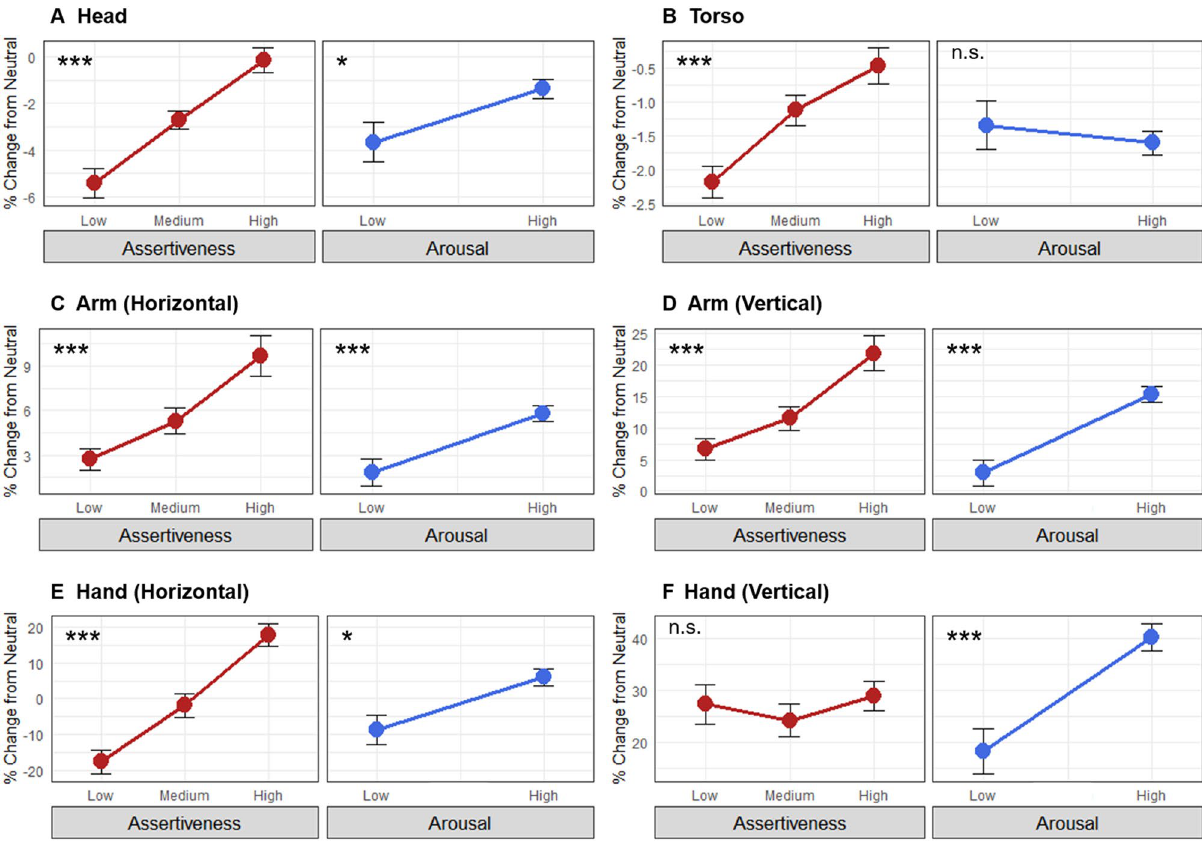
Figure 3. Body effects of character assertiveness and emotional arousal. The figure shows the effect of character assertiveness (left panels in red) and emotional arousal (right panels in blue) on the parameter means of the 6 body segments. Values for each segment are the percent change relative to the neutral emotion condition, which corrects for the diversity of body dimensions across participants. Error bars indicate the standard error of the mean. Significance values are from a repeated-measures ANOVA regression model for the main effects of character dimensions. * p < .05 and *** p < .001 after Bonferroni correction, n.s., not significant. See Table 1 for the full character descriptions and Table 2 for the full emotion